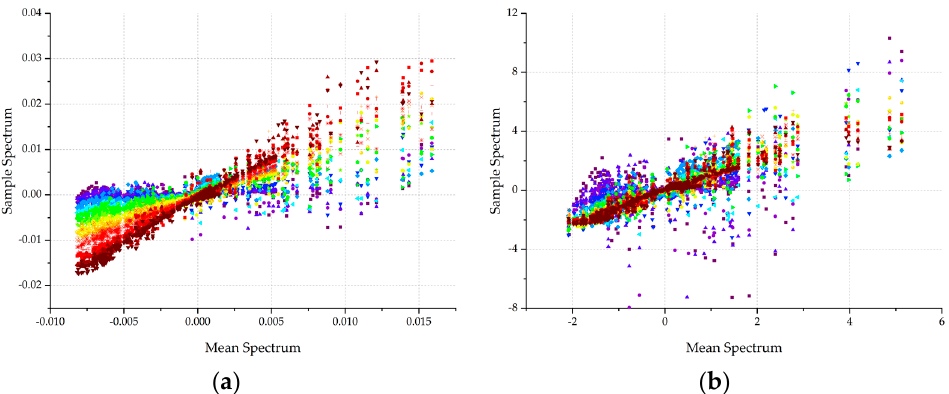
Figure 4. FTIR scatter effect plot for chromatography, ( a ) show scatter effects of raw spectral data and ( b ) show scatter effects after preprocessing.